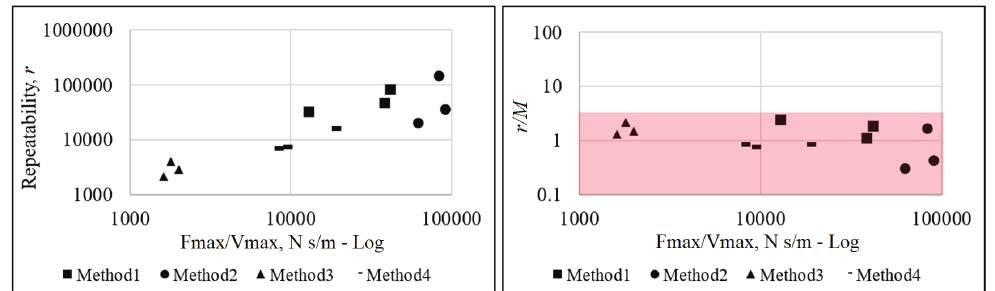
Figure 7. Comparison of Mechanical Impedance considering the four methods used (time-based values)